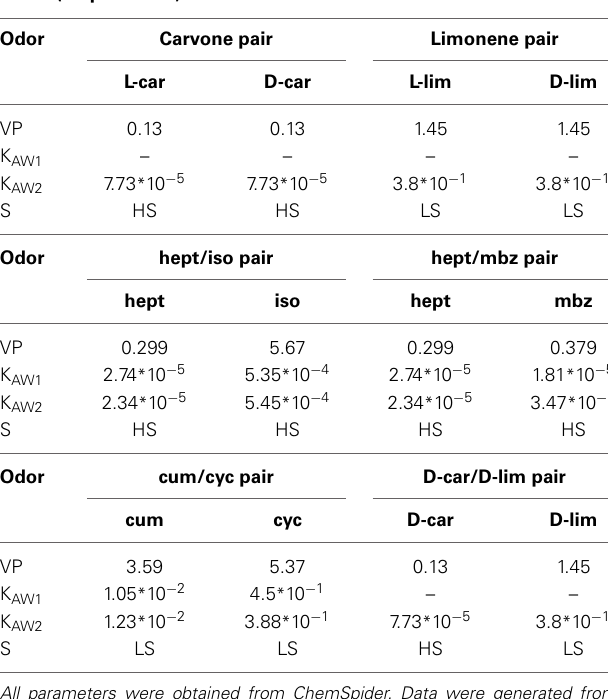
Table 1 | Physicochemical properties of the odorant molecules: vapor